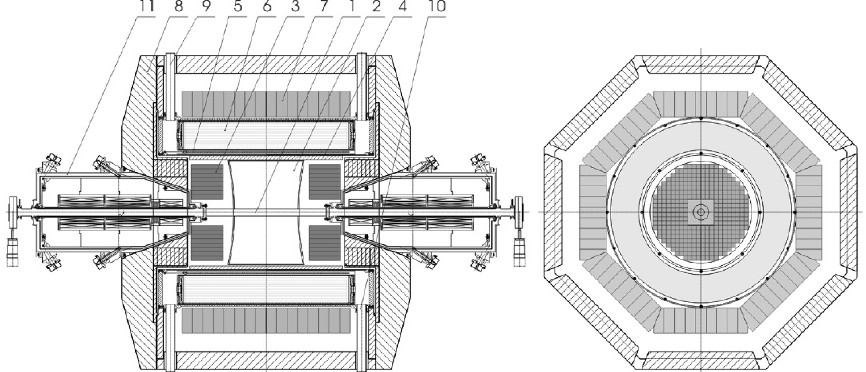
Figure 1 . The schematic view of the CMD-3 detector. (1) beam pipe, (2) drift chamber, (3) BGO endcap calorimeter, (4) Z-chamber, (5) superconducting solenoid, (6) liquid xenon calorimeter, (7) CsI barrel calorimeter, (8) iron yoke, (9) liquid He supply, (10) vacuum pumpdown, (11) VEPP-2000 superconducting magnetic